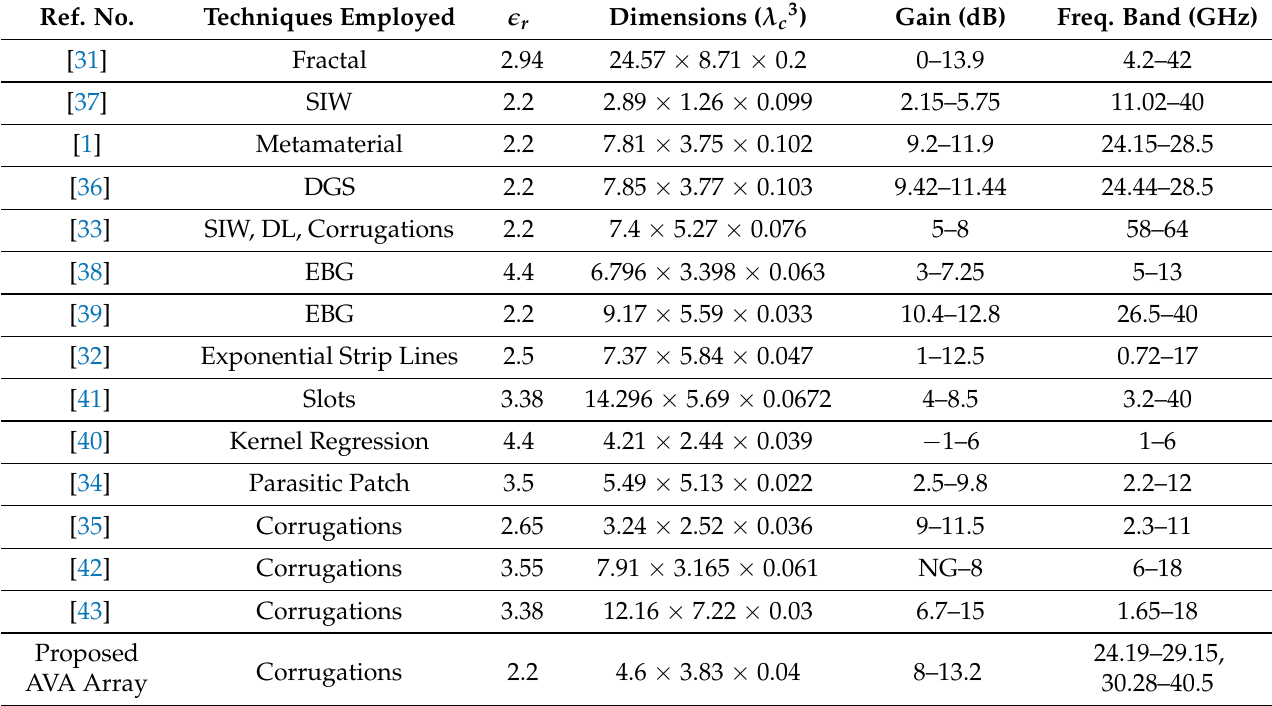
Table 2. The comparison of the proposed AVA with other